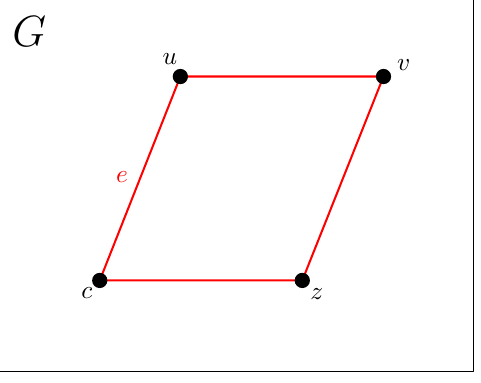
(b) The transformation ˜ G = (˜ V , ˜ A ) of G ; ele- ments in ˜ V and ˜ A induced by V are black, those in ˜ A induced by E are red.